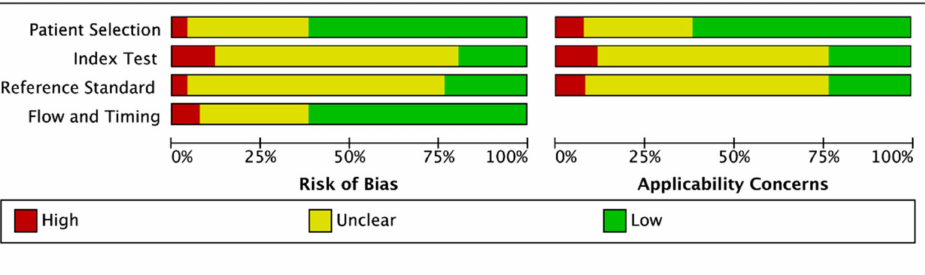
Figure 2. The risk of bias in the included studies.